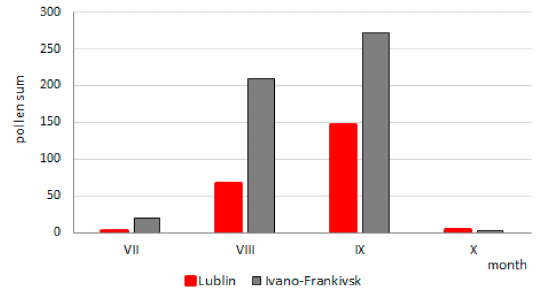
Figure 3. Frequency of Ambrosia pollen in the air of Lublin and Ivano-Frankivsk in particular months of the year; means for